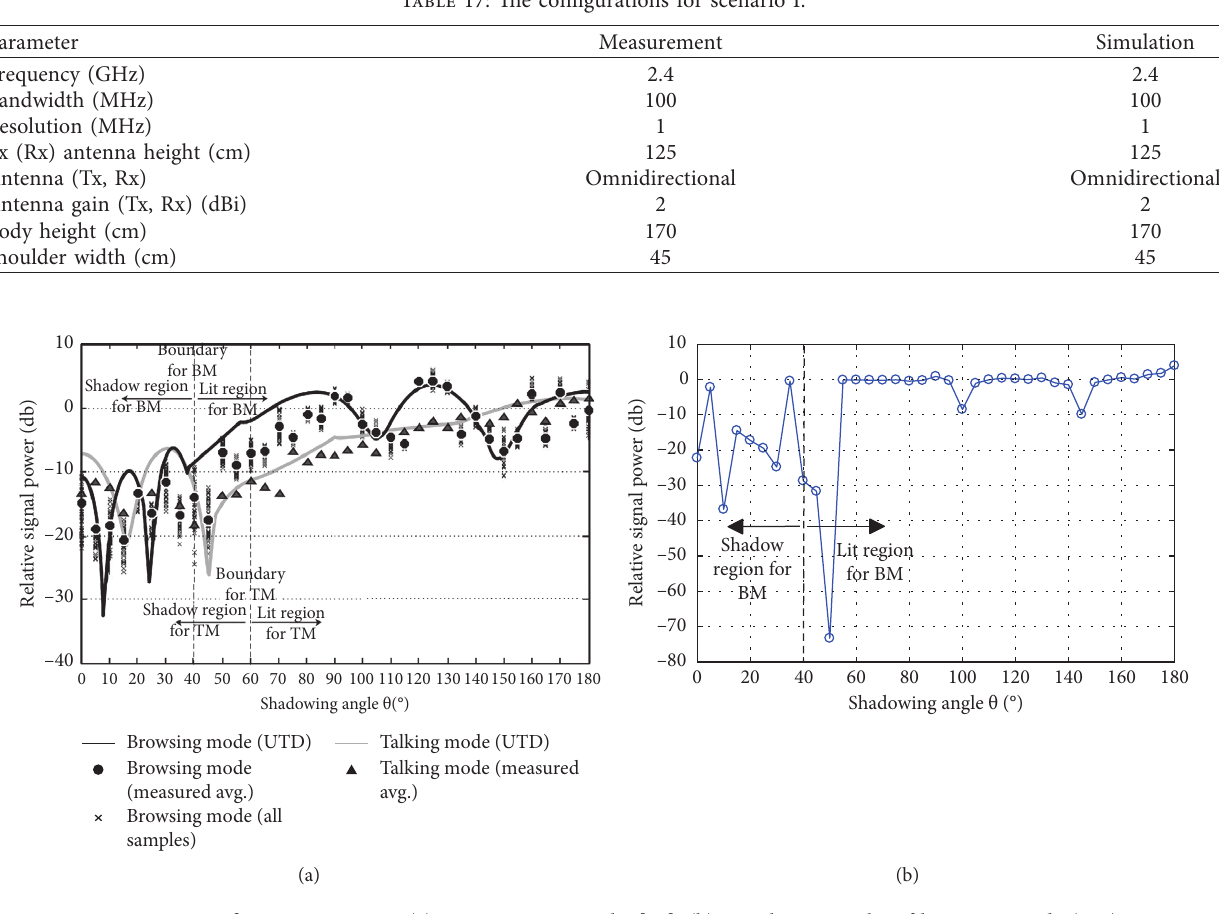
Figure 18: Verification scenario I. (a) Top view of the measurement scenario setup [26]. (b) Simulation scenario setup. Table 17: The configurations for scenario I.